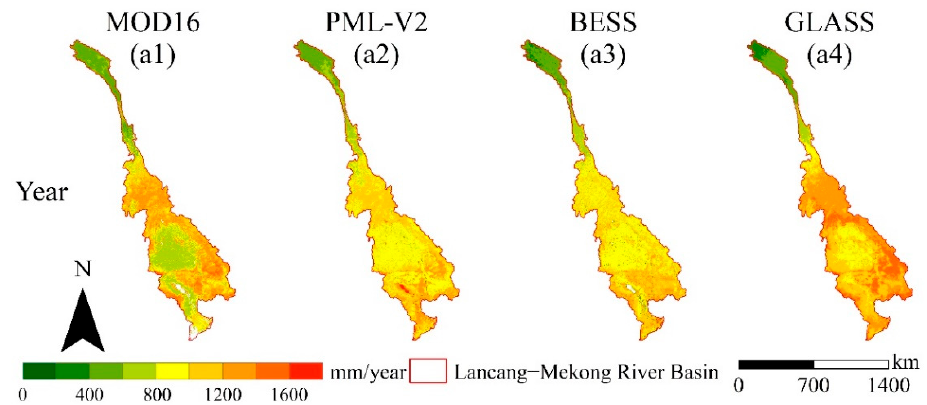
Figure 4. Spatial ET of multi-year average of the four products. ( a1 ), ( a2 ), ( a3 ) and ( a4 ) are multi-year average ET of MOD16, PML-V2, BESS and GLASS respectively.